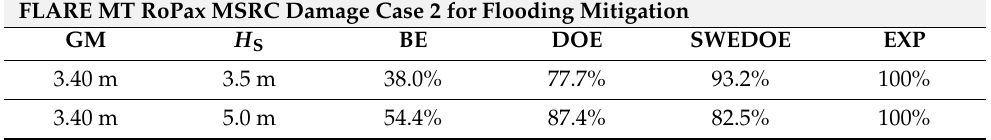
Table 4. Computed Times to Capsize TTC in percent in comparison with experimental values.